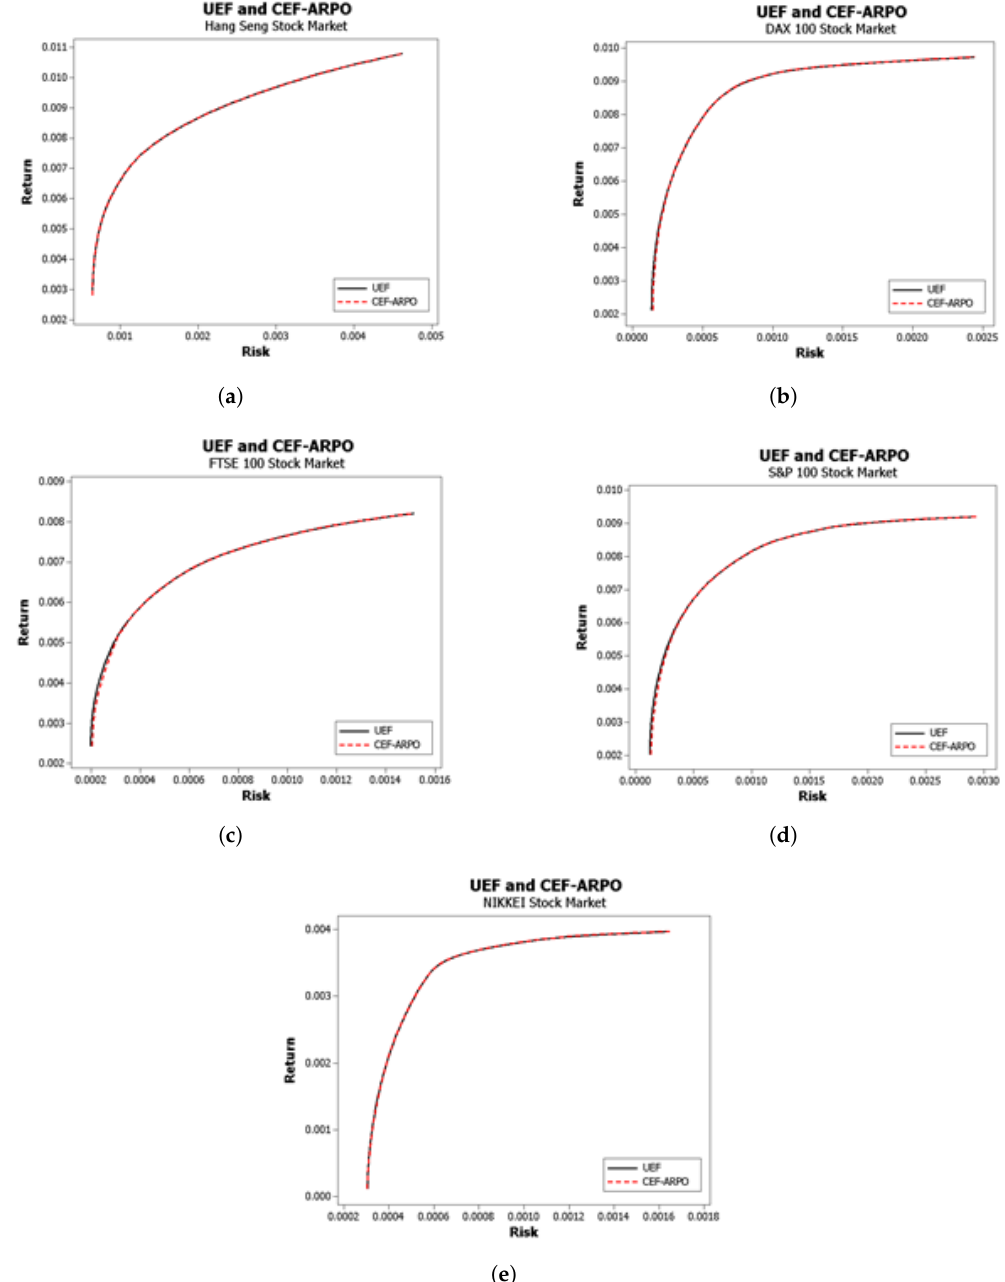
Figure 1. UEF and CEF-ARPO. ( a ) Panel A—Hang Seng Stock Market (Hong Kong); ( b ) Panel B—DAX 100 Stock Market (Germany); ( c ) Panel C—FTSE 100 Stock Market (UK); ( d ) Panel D—S&P 100 Stock Market (US); ( e ) Panel E—NIKKEI Stock Market (Japan). Notes: Figure 1 illustrates the UEF and the CEF-ARPO for the five instances (Panel A—Hang Seng, Panel B—DAX 100, Panel C—FTSE 100, Panel D—S&P 100 and Panel E—NIKKEI 225). The UEF is represented with a black solid line, whereas the CEF-ARPO is represented with a dash red line. Portfolio variance is depicted on the horizontal axis, whereas the required rate of return is depicted on the vertical axis. The minimum average percentage loss is 0.00399% for the Hang Seng portfolio, 2.45403% for the DAX 100 portfolio, 1.88340% for the FTSE100 portfolio, 4.65095% for the S&P 100 portfolio and 0.20189% for the NIKKEI 225 portfolio. Table 3 presents the UEF and the CEF-ARPO for the DAX 100 portfolio for 10 initial points and 10 last values of